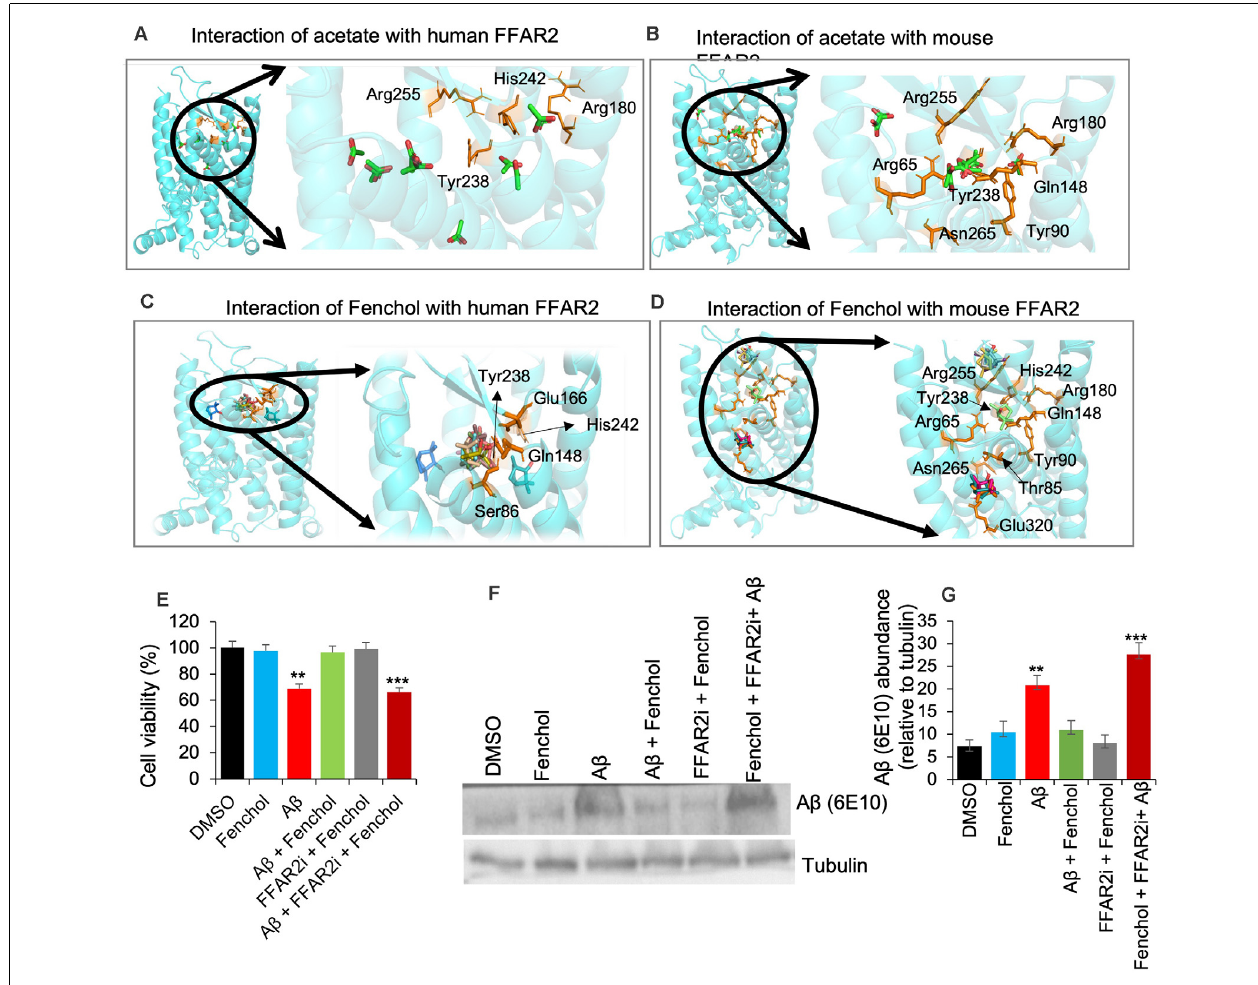
FIGURE 3 | Fenchol binds to the FFAR2 active site and its neuroprotective effects are FFAR2 signaling dependent. (A–D) Interactions of Fenchol with human (C) and mouse (D) FFAR2 and its comparison with known FFAR2 agonist-Acetate (A,B) . (E) Fenchol treatment significantly reduced the A β -induced decline in cell viability (E) and A β -accumulation (F,G) in SK-N-SH cells on FFAR2 dependent manner. Data are mean ± SEM ( n =3 independent experiments in triplicate). ** P < 0.01; *** P <